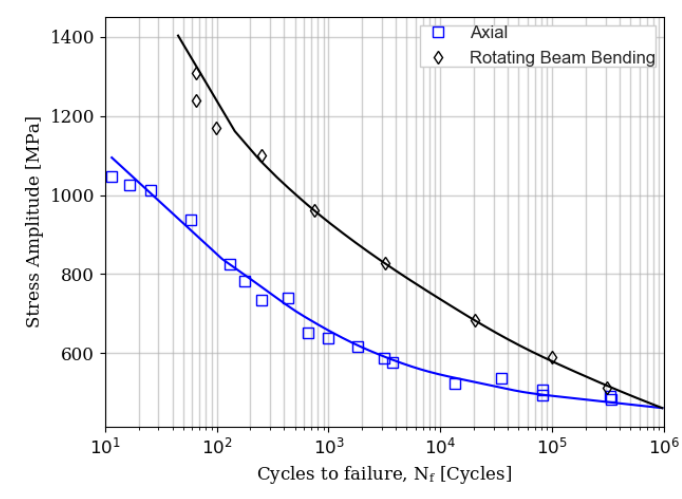
Figure 13: Fatigue performance of 4130 Steel under axial loading and rotating bending [25].